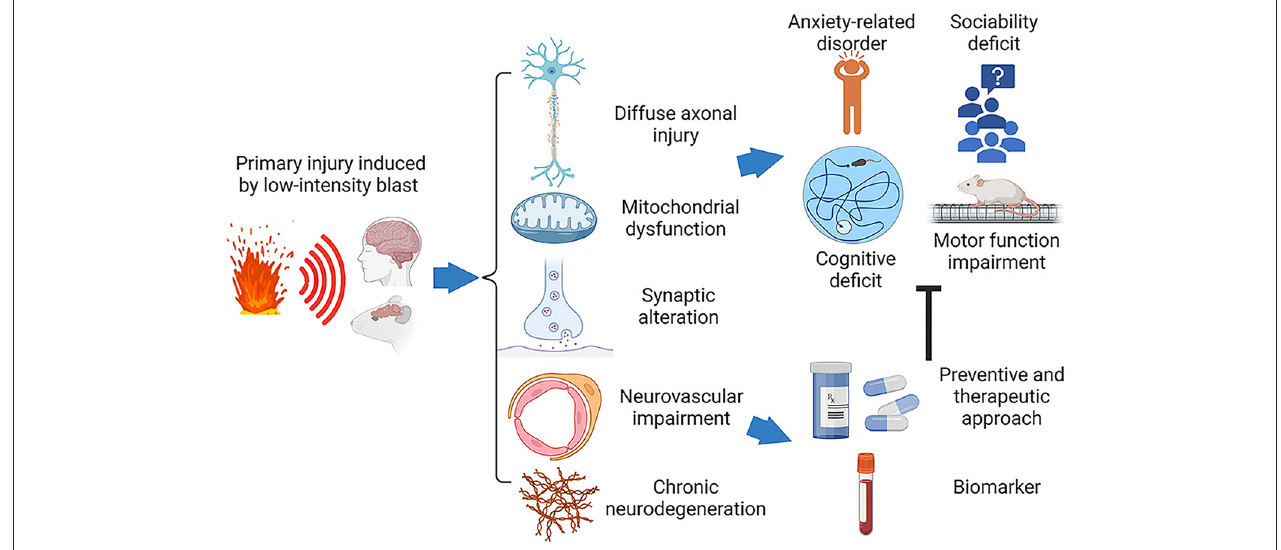
FIGURE 1 | Schematic diagram of the pathophysiology and behavioral impairments in LIB-induced mTBI. Traumatic brain injury induced by primary low-intensity blast (LIB) results in cellular and subcellular deficits, including diffuse axonal injury, mitochondrial dysfunction, synaptic alteration, neurovascular impairment, and chronic neurodegeneration. These pathophysiological abnormalities lead to neurobehavioral dysfunctions, such as cognitive deficits, anxiety-related disorder, sociability deficit, and motor function impairment. The ongoing efforts targeting on these pathophysiological abnormalities to advance development of preventive and therapeutic solutions and specific biomarkers for diagnosis, prognosis and